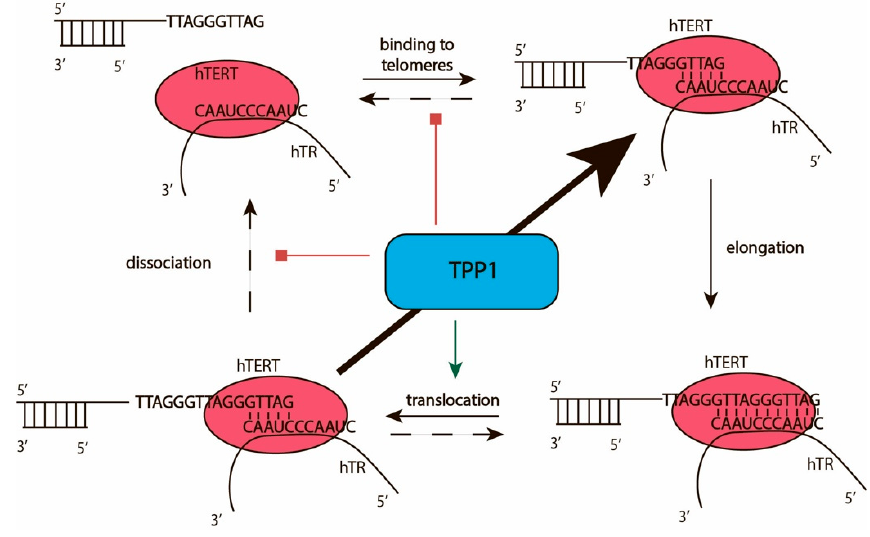
Figure 3. Catalytic cycle of telomerase. Scheme illustrating the telomerase active cycle and its modulation by TPP1.